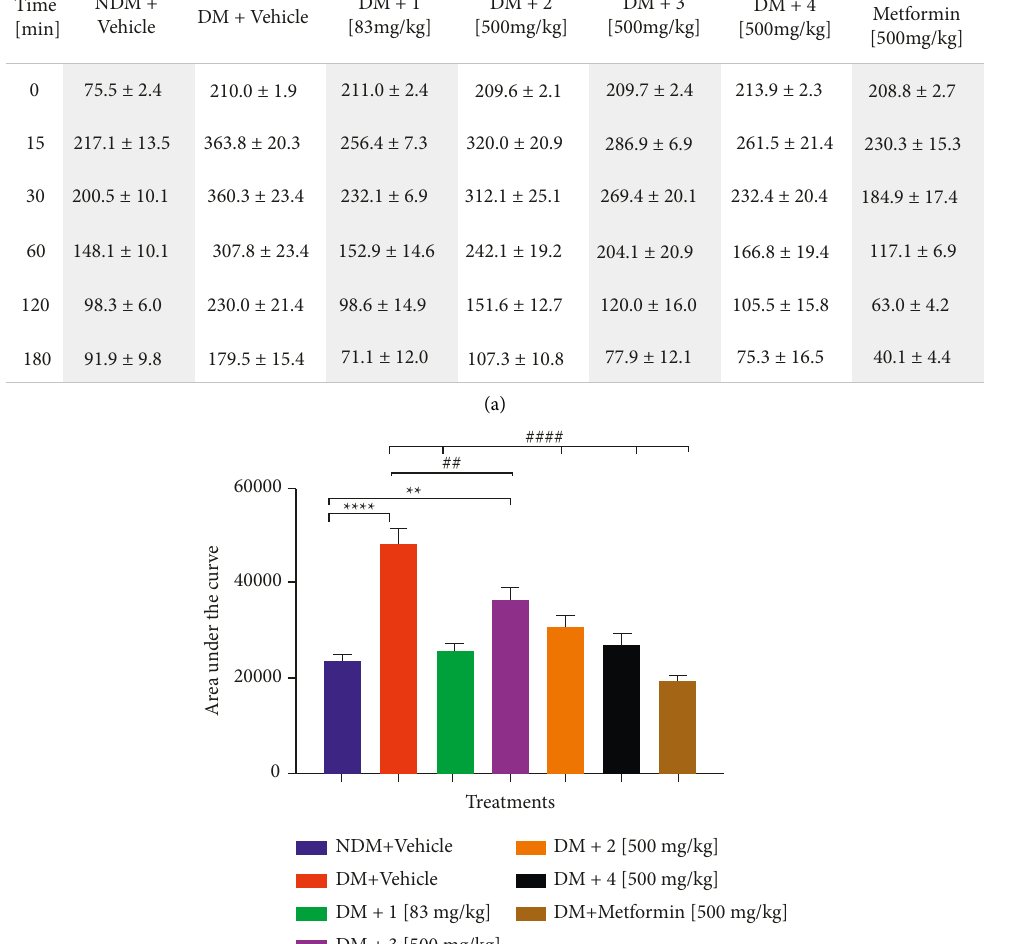
3. NDM non-diabetic (cid:31) (cid:31) 2- O-β glucopyranosyl- (cid:31) 0 . 01 ≤